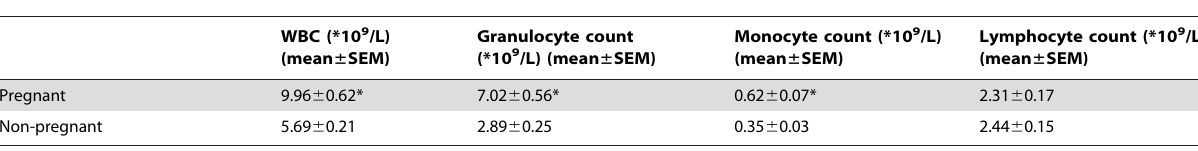
Table 2. Total white blood cell count and differential cell counts.